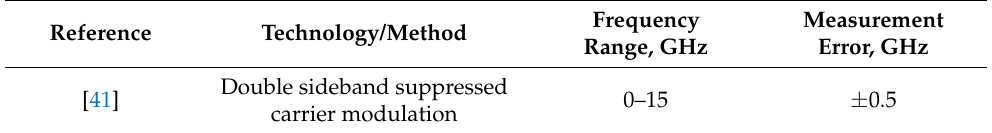
Table 6. Performance of IFM techniques based on Fano resonance.